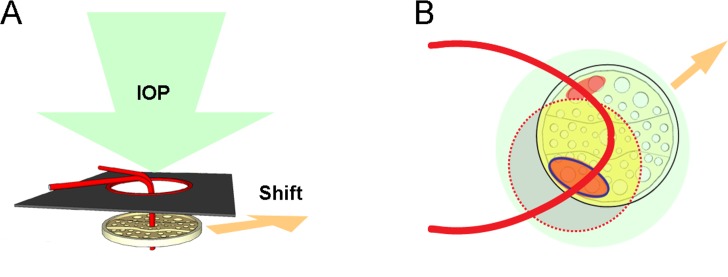
Effects of high intraocular pressure (IOP) and lamina cribrosa (LC) shift in high-tension glaucoma.(A) IOP can exert uniform force over the LC (green arrow). (B) The en face view. The LC shift (orange arrow) would make the pores on the side opposite to the shift more susceptible to IOP and glaucomatous damage. The red-dotted circles indicate the BMO margin, the black-solid circle indicates the LC, the portions in yellow color represent the visible part of the LC via funduscopic examination (clinical disc margin), and the red ellipsoids indicate the superotemporal and inferotemporal pores that are more susceptible to glaucomatous damage. Both pores would be affected by IOP (green circle), while the pores on the side opposite to the shift (the red ellipsoid marked with blue line) would be doubly affected by IOP (green circle) and shift-associated tensile stress (orange arrow).